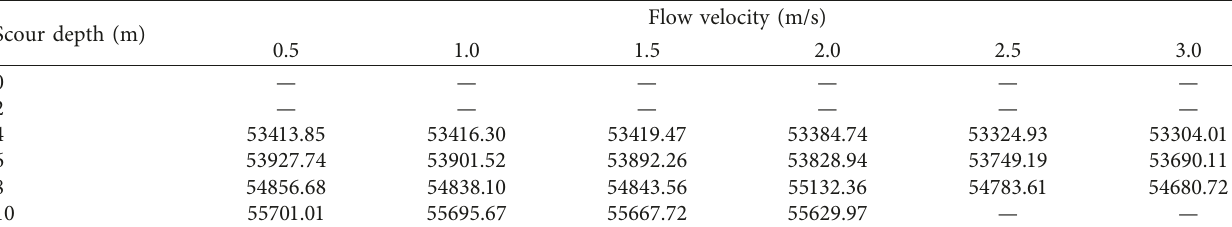
Table 5: The maximum axial force of fluid-solid